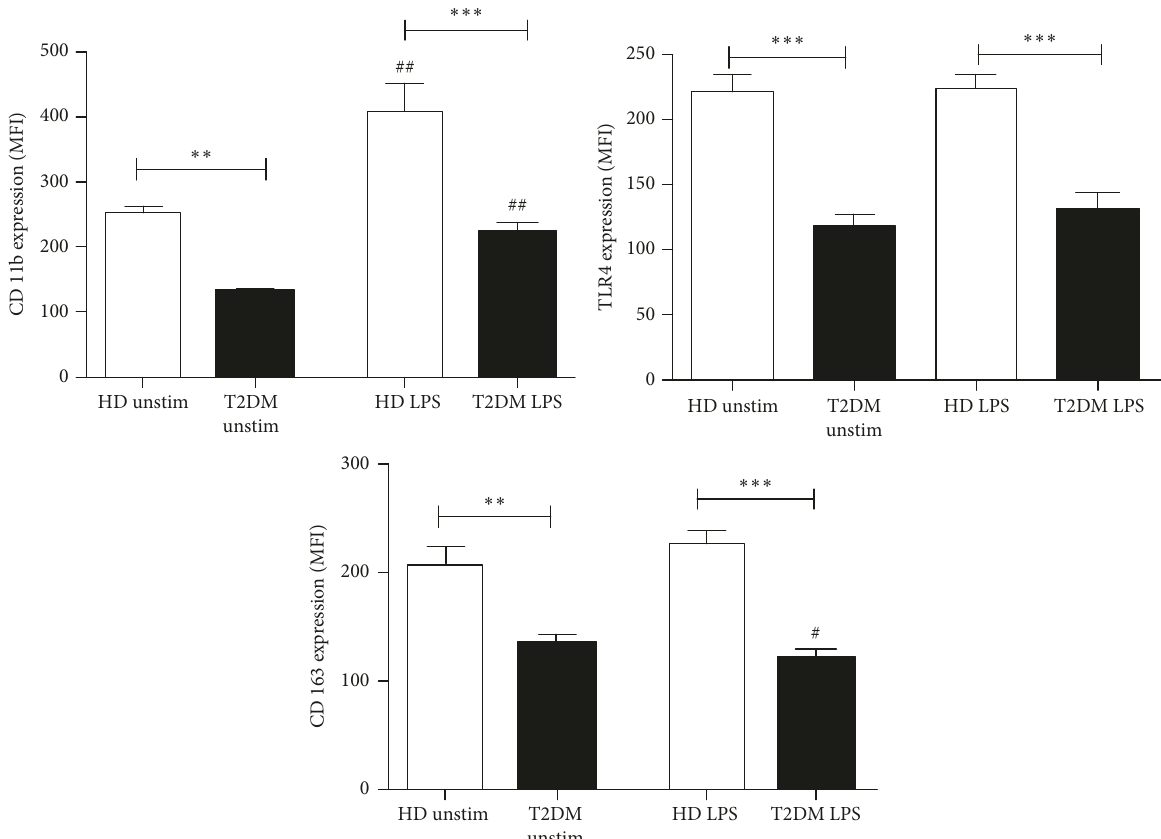
Figure 1: Surface expression of CD11b, CD163, and TLR4 on monocytes after cultivation of whole blood from healthy donors (HD, white bars) and type 2 diabetic (T2DM, black bars) patients with medium alone (unstimulated) or 100ng/ml LPS for 24 hours. Data are given as median fluorescent intensity (MFI). Results are presented as mean ± SE. # 𝑝 < 0.05 ; ## 𝑝 < 0.01 versus unstimulated cultures; ∗∗ 𝑝 < 0.01 ; ∗∗∗ 𝑝 < 0.001 versus healthy